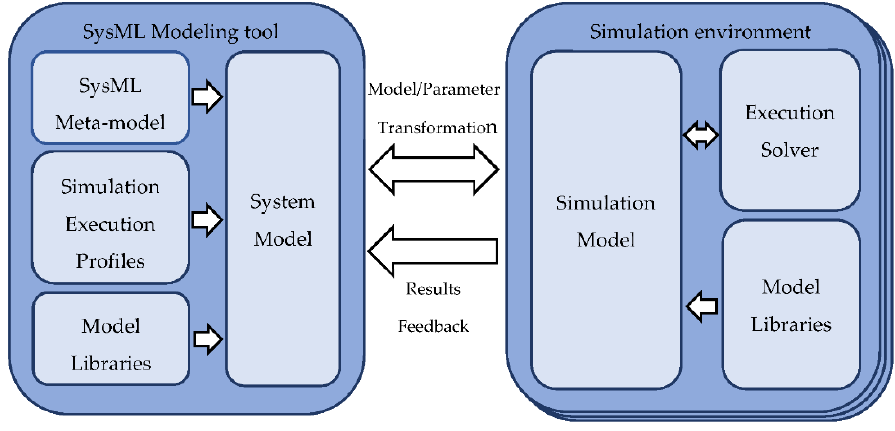
Figure 1. A common SysML–Simulation integration setting.